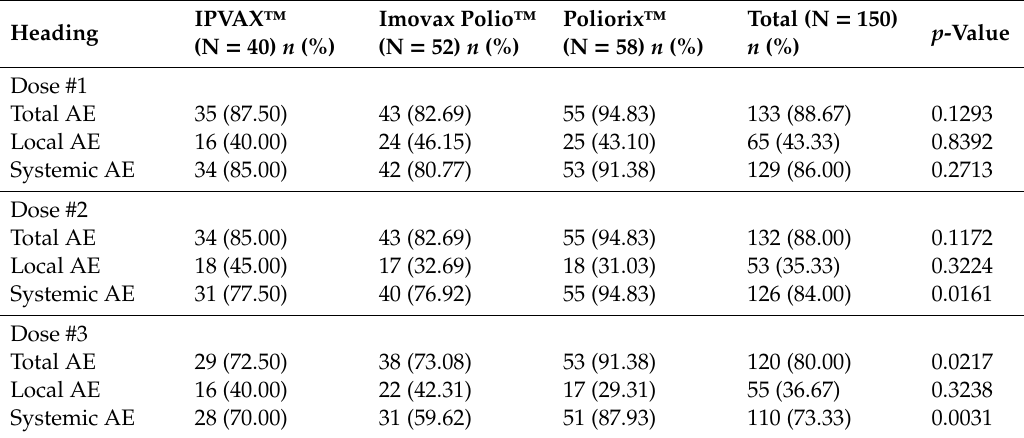
Table 3. Incidence of adverse events after